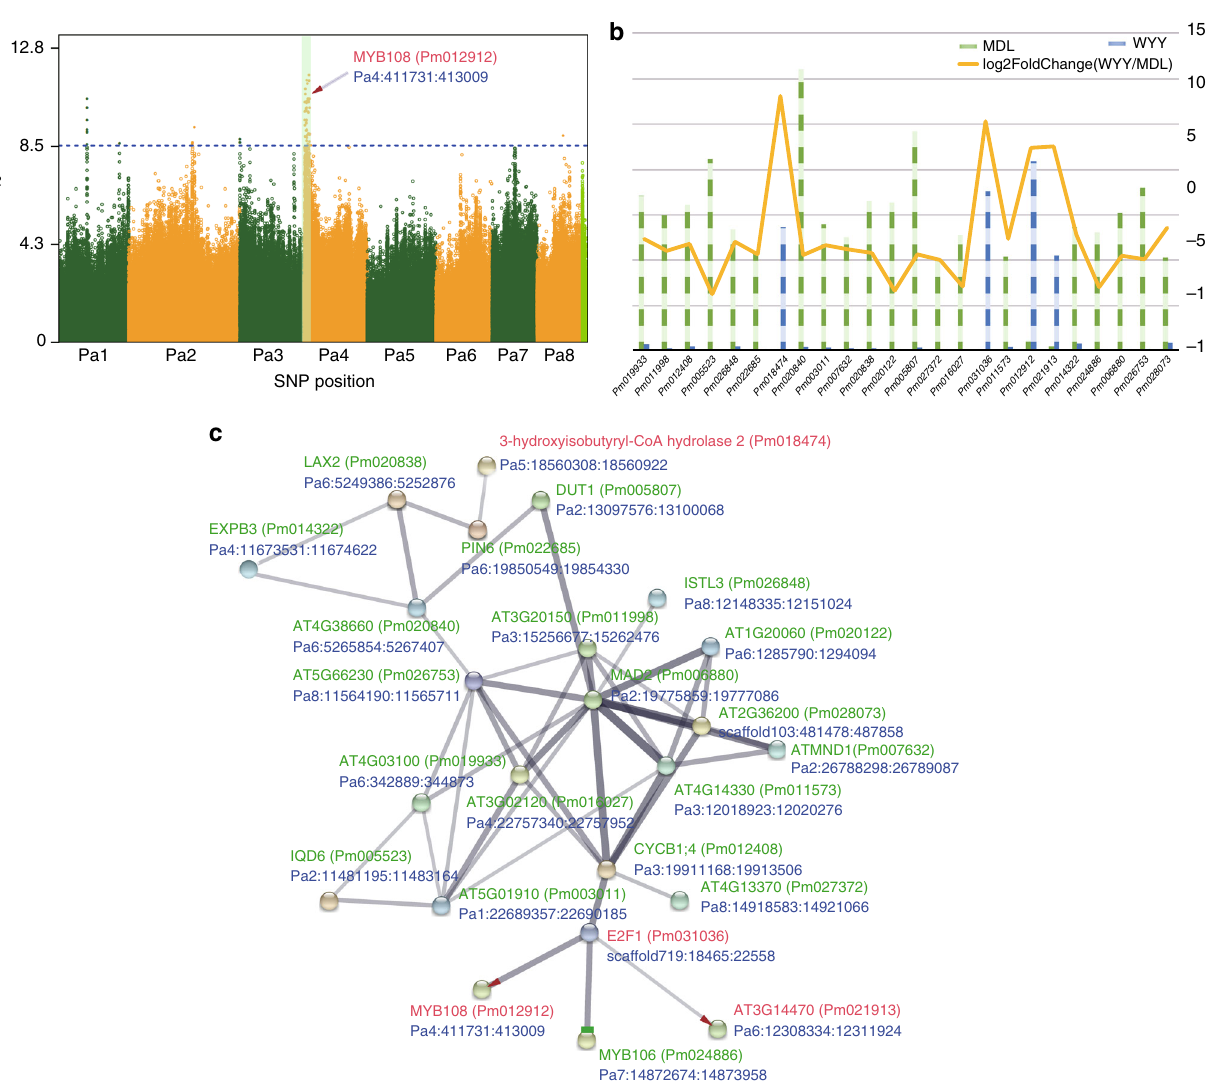
Fig. 4 GWAS results of petal color and other three fl oral traits. a Manhattan plot of the petal color trait on the eight chromosomes of mei. b Comparison of the transcript expression of SEGs located in the Pa4 region signi fi cantly associated with petal color, stigma color, calyx color, and bud color. c The co- expression network of SEGs based on the interaction relationships of Arabidopsis thaliana orthologs in the String